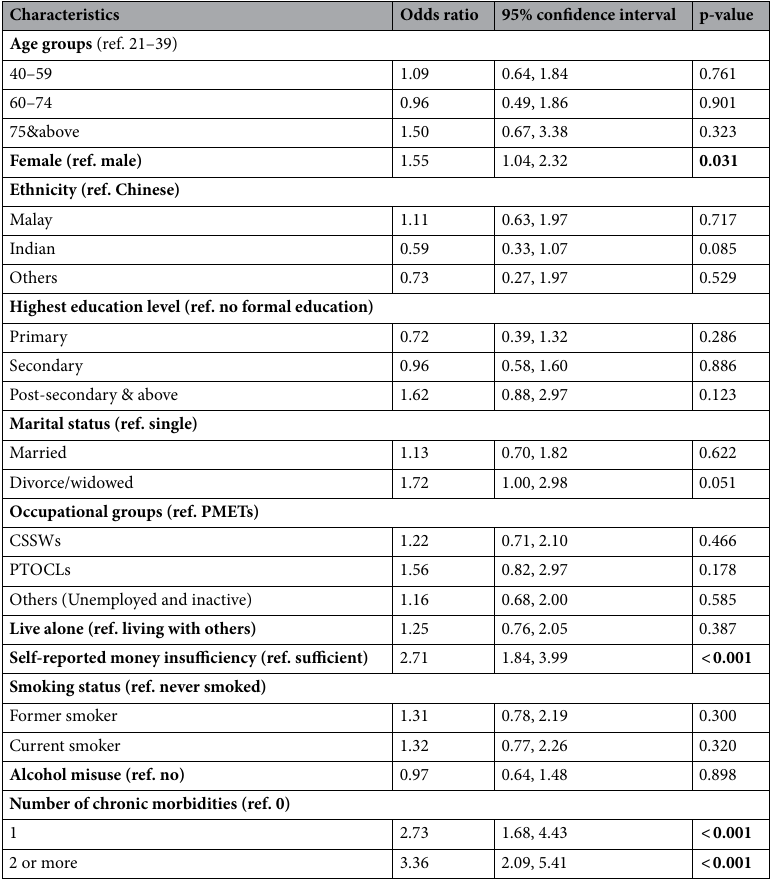
Table 2. Association between socio-demographics and chronic low back pain using logistic regression. Significant values are in bold. PMETs Professionals, Managers, Executives and Technicians, including Major Group 1–3, X), CSSWs Clerical, Sales and Service Workers, including Major Group 4–5; PTOCLs Production and Transport Operators, Cleaners and Labourers, including Major Group